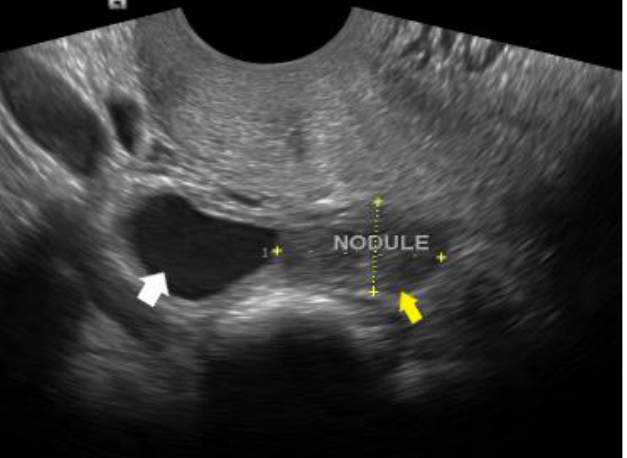
Figure 8. DIE nodule of the uterosacral ligament, visualized as a hypoechoic lesion (white arrow) in the sagittal plane.